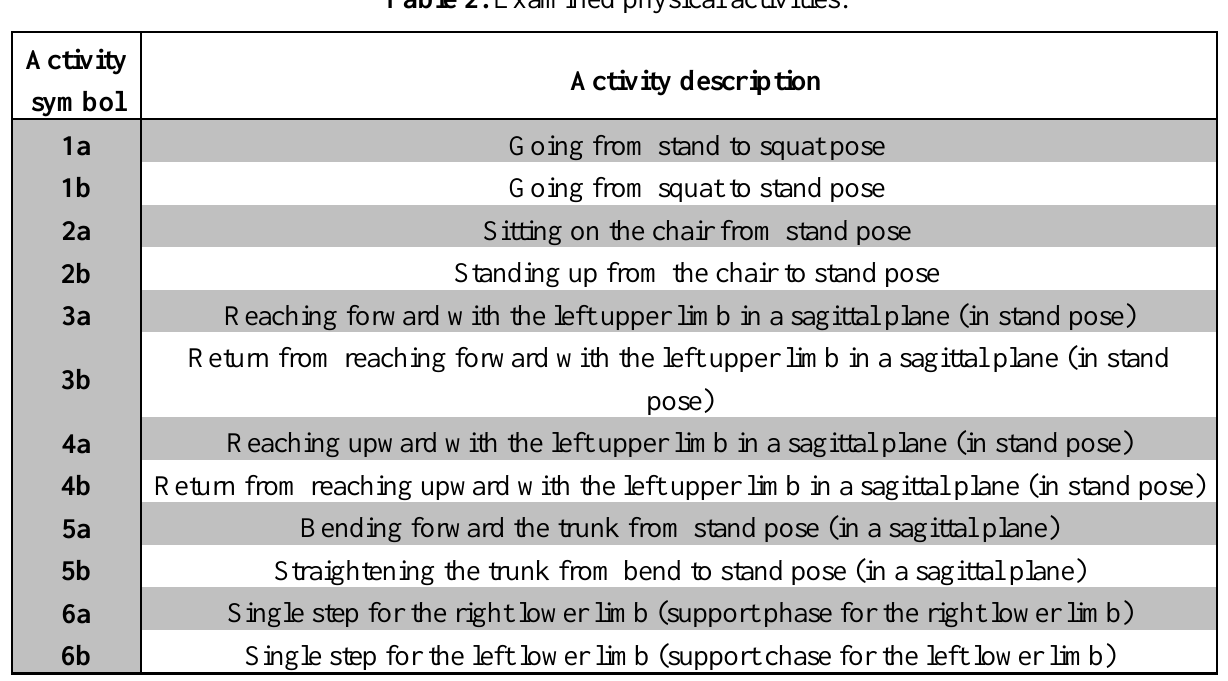
Table 2. Examined physical